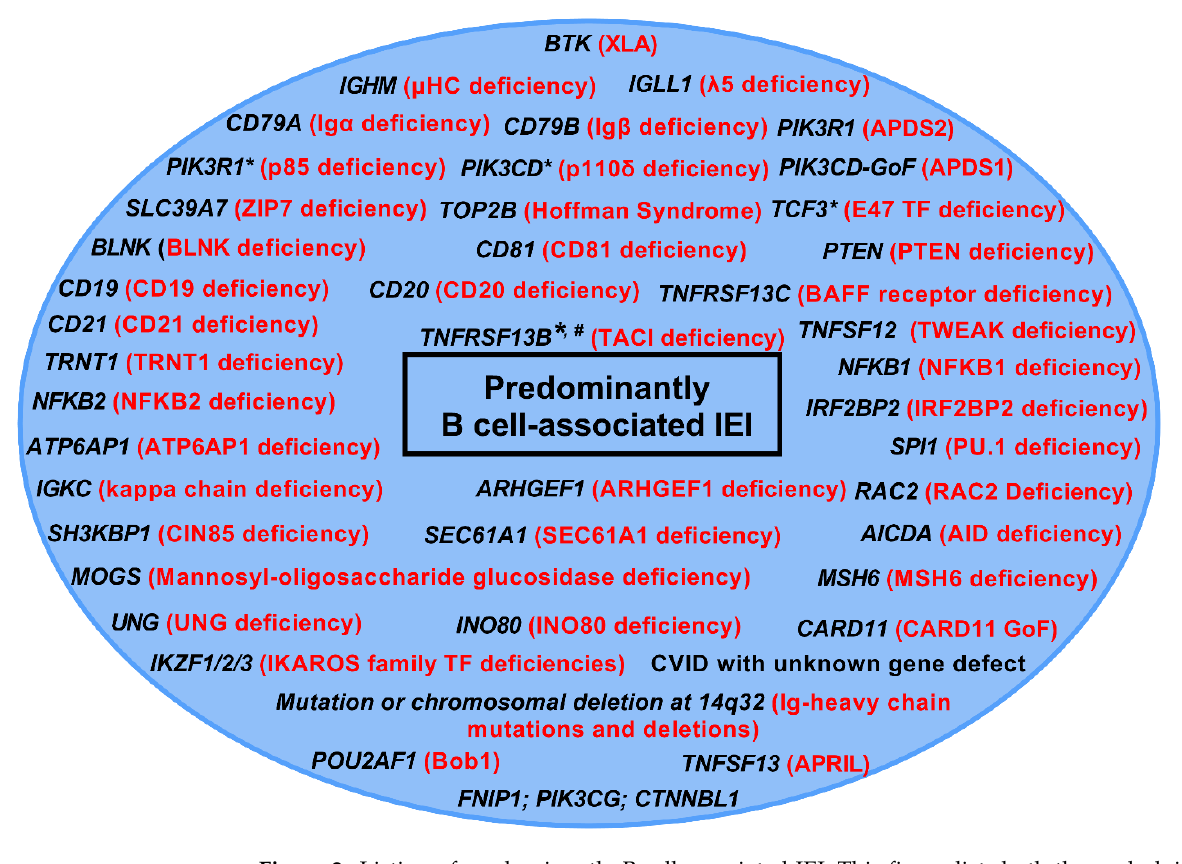
Figure 2. Listing of predominantly B cell associated IEI. This figure lists both the underlying genetic defects (in black) and name of the disease (in red), based on the 2019 International Union of Immunological Societies (IUIS) update, as well as the 2022 update on the classification of human inborn errors of immunity. * These defects can display both autosomal recessive (AR) as well as autosomal dominant (AD) patterns, and these patterns can affect the disease phenotype as well as the degree to which the different Ig isotypes and B cell numbers are decreased. # These variants can be considered disease − modifying rather than disease − causing, since healthy individuals can also harbor heterozygous variants of this gene. TF: transcription factor.